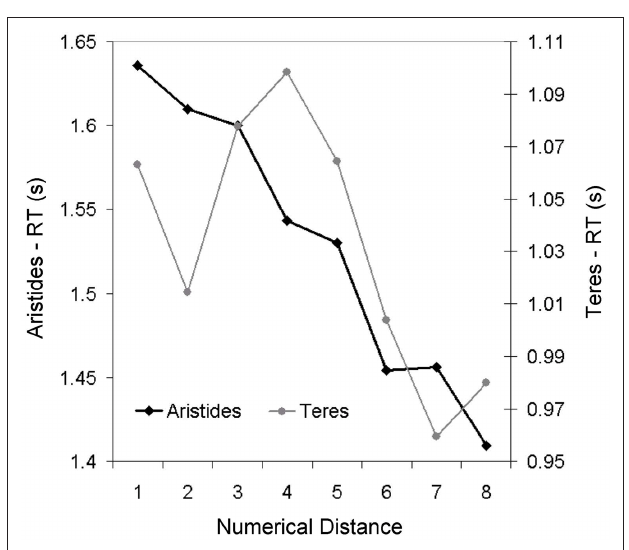
Figure 8 | response time for experiment 2B as a function of the numerical distance between the values being